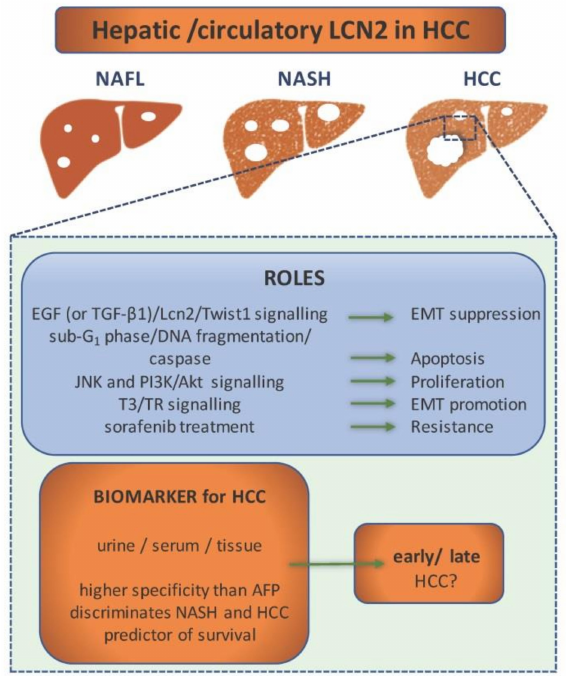
Figure 3. LCN2 as a component in hepatocellular carcinoma (HCC) pathogenesis and diagnostics. In the pathogenesis of HCC, LCN2 is included in various signalling pathways that regulate processes as epithelial-to-mesenchymal transition (EMT), apoptosis, proliferation, and chemoresistance. Depend- ing on the activated signalling pathway, it can either act as a tumor suppressor or promoter. Altered expression level of LCN2 in urine, serum, and tissue during the pathogenesis of HCC makes it a potential biomarker. It shows higher specificity in diagnosis of HCC than α -fetoprotein (AFP). LCN2 levels discriminate HCC from other non-alcoholic fatty liver disease (NAFLD) stages and can even predict patient survival. However, it cannot discriminate between early and late